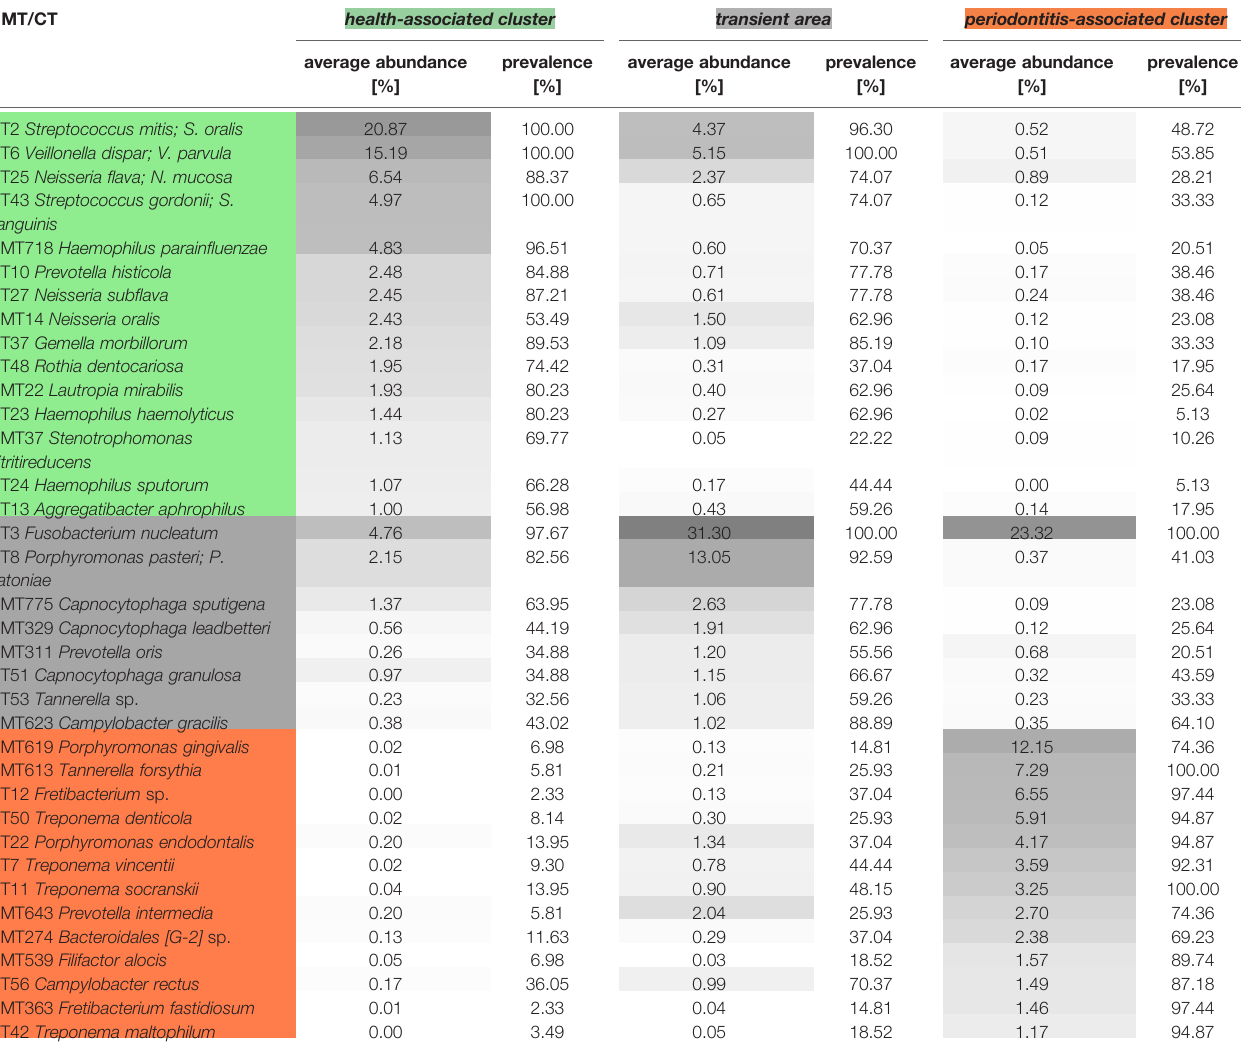
TABLE 1 | The average relative abundance and representation of selected taxa in the health-associated cluster, transient area, and periodontitis-associated cluster.